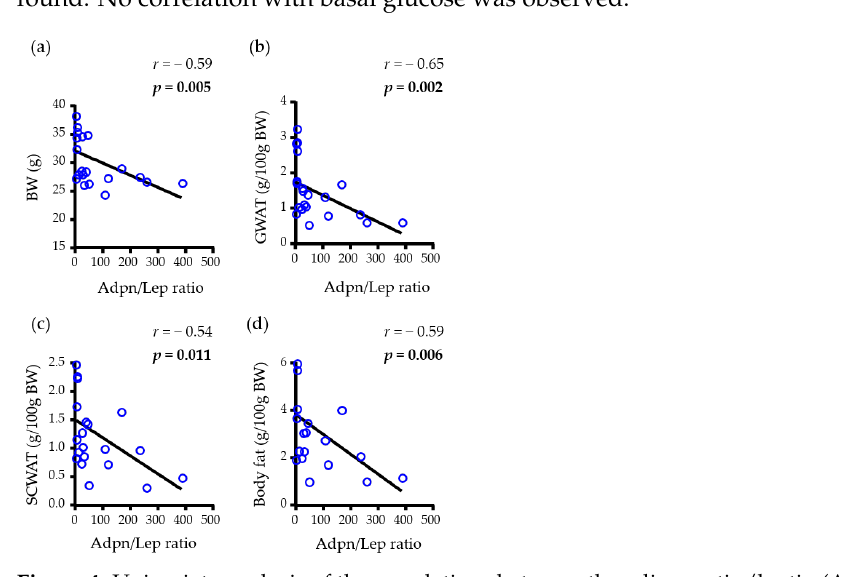
Figure 4. Univariate analysis of the correlations between the adiponectin/leptin (Adpn/Lep) ratio with ( a ) body weight (BW), ( b ) gonadal (GWAT), ( c ) subcutaneous (SCWAT) and ( d ) whole-body fat content of male animal. Adpn/Lep ratio, adiponectin/leptin ratio; BW, body weight; r , Pearson correlation coefficient; p , significance value. p values lower than 0.05 are highlighted with bold text. Regarding female mice, a negative correlation between the Adpn/Lep ratio and BW ( r = − 0.71, p < 0.001), GWAT ( r = − 0.67 p < 0.001), SCWAT ( r = − 0.75, p < 0.001) and total WAT ( r = − 0.74, p < 0.001) was also observed. To further reinforce the accuracy of the Adpn/Lep ratio as an important marker of metabolic improvement, the correlation between the Adpn/Lep ratio and basal glucose was also analyzed, and a negative correlation between them was identified ( r = − 0.44, p = 0.048) (Figure 5).